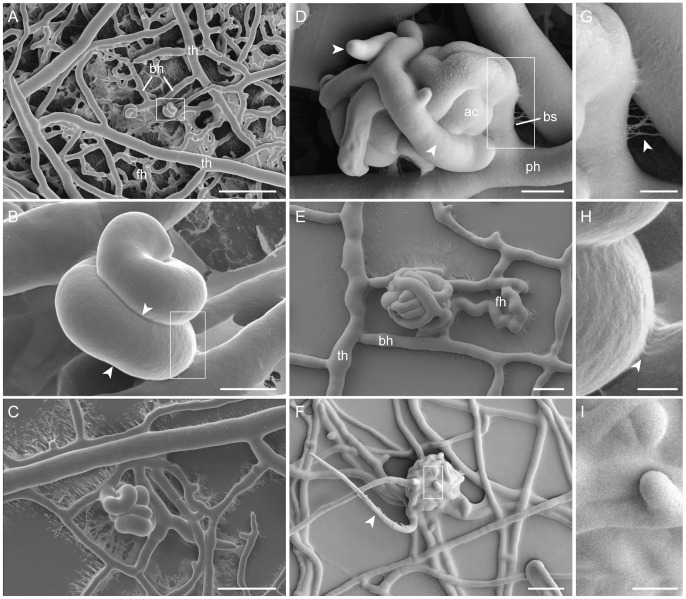
Protoperithecial morphogenesis of N. crassa wild type.LTSEM of the main stages of protoperithecial development. (A) Two ascogonial coils differentiated from the vegetative mycelium of a two day-old culture. These two coils have formed on branches (bh) off the main arterial trunk hyphae (th). Some of the surrounding branches have fused with each other, they are therefore considered to be fusion hyphae (fh). Vegetative hyphal fusion is instrumental in the establishment of a fully co-operative interconnected mycelium. Scale bar, 50 µm. (B) Higher magnification of the ascogonial coil boxed in (A). On careful inspection a septum can be seen on the lower part of the coil (aligned with arrowheads). Scale bar, 5 µm. (C) A slightly expanded ascogonial coil again formed on a side branch of a trunk hypha, the coil is being wrapped around by enveloping hyphae. Scale bar, 20 µm. (D) A slightly later stage where enveloping hyphae (arrowheads) originating from the ascogonium have wrapped around the central ascogonial coil (ac). These enveloping hyphae exhibit septation and branching. The ‘parent hypha’ (ph) of the ascogonial coil can be clearly defined, and is separated from the developing fruitbody by a basal septum (bs). (E) The subspherical shape of the protoperithecium becomes evident after additional enveloping hyphae have formed a protective casing around the ascogonium. Trunk hyphae (th), their branches (bh) and fusion hyphae (fh) can be clearly distinguished. Scale bar, 5 µm. (F) Mature protoperithecium, with visible ECM secretion ‘gluing’ enveloping hyphae together, and a trichogyne (arrowhead) emerging from its center. Scale bar, 20 µm. (G) Enlarged view of the boxed area in (D) showing ECM strands between hyphae (arrowhead). Scale bar, 2 µm. (H) Enlarged view of the boxed area in (B) showing ECM strands (arrowhead) between the tightly attaching revolutions of the ascogonial coil. Scale bar, 1 µm. (I) Enlarged view of the boxed area in (F) showing the surface hyphae of the protoperithecium evenly covered in ECM. Scale bar, 5 µm.